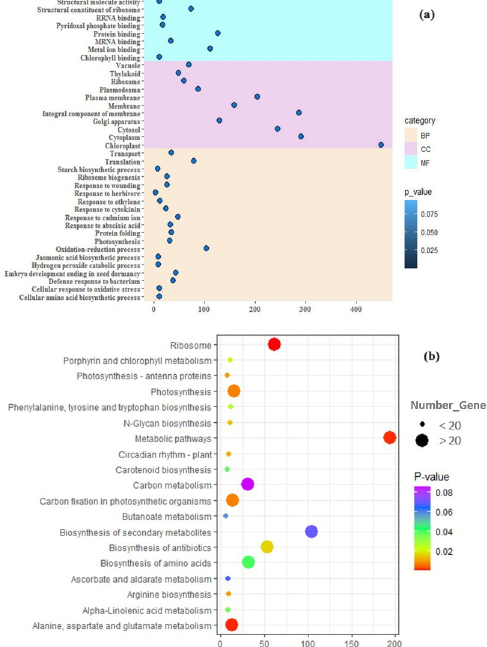
Fig 3. Gene enrichment and pathway analyses of biotic DEGs. (a) Gene ontology was performed using DAVID. The most significantly ( P-value � 0.05) enriched GO terms in Biological Process (BP), Molecular Function (MF), and Cellular Component (CC) categories related to the defense responses are presented. The horizontal axis shows the number of genes based on the P-value , while the vertical axis represents Go terms. (b) Shows KEGG pathway analysis of biotic DEGs. Y-axis shows the pathways and the X-axis shows the number of DEGs enriched in the pathways. The colors of each bubble are determined based on the P-value of the identified pathways. Size of the bubble represents number of DEGs enriched in the pathways. The figures were drawn using R and ggplot